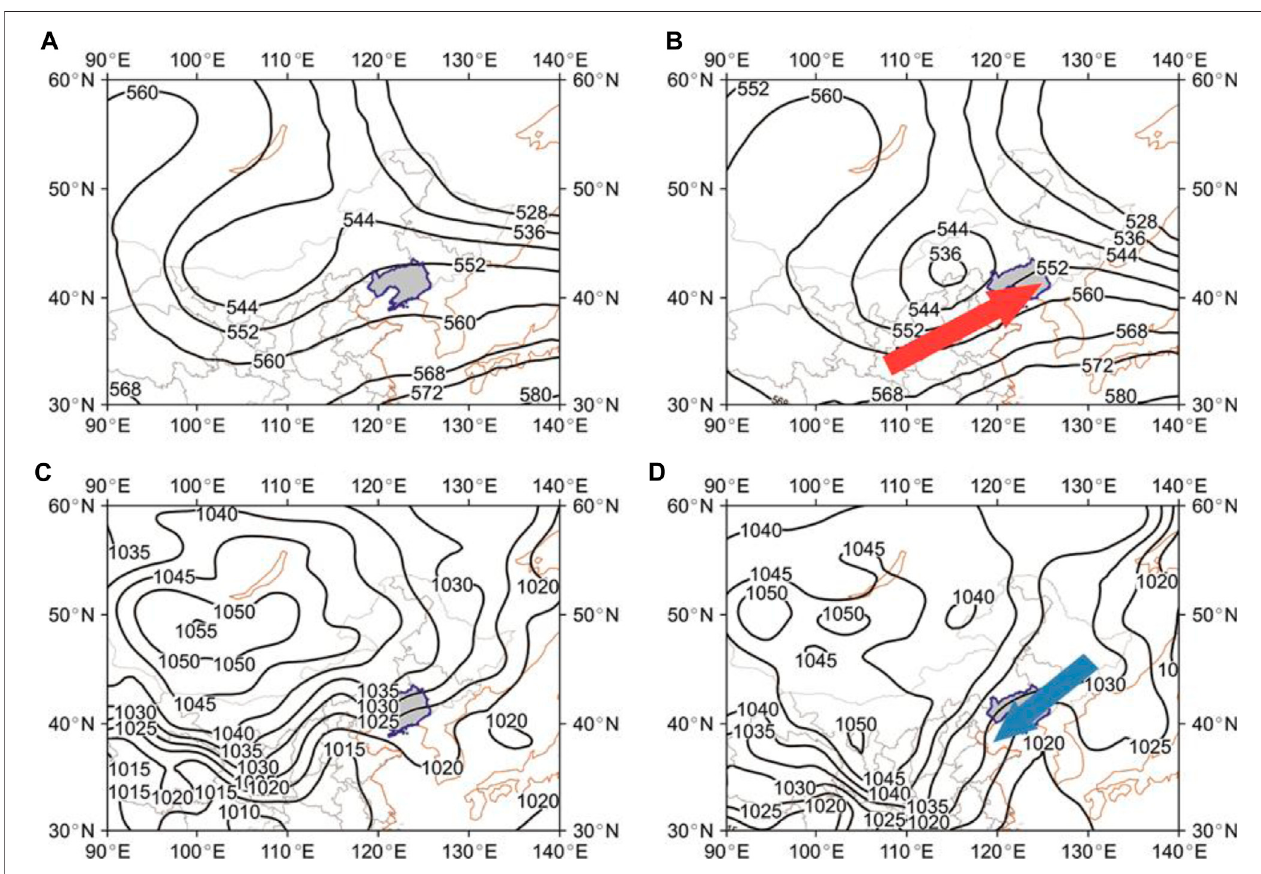
FIGURE 4 | Geopotential height at the 500 hPa level (A) , 0:00 on Day 1; (B) , 0:00 on Day 2) (unit: 10 gpm) and sea level (C) , 0:00 on Day 1; (D) , 0:00 on Day 2) (unit: hPa).